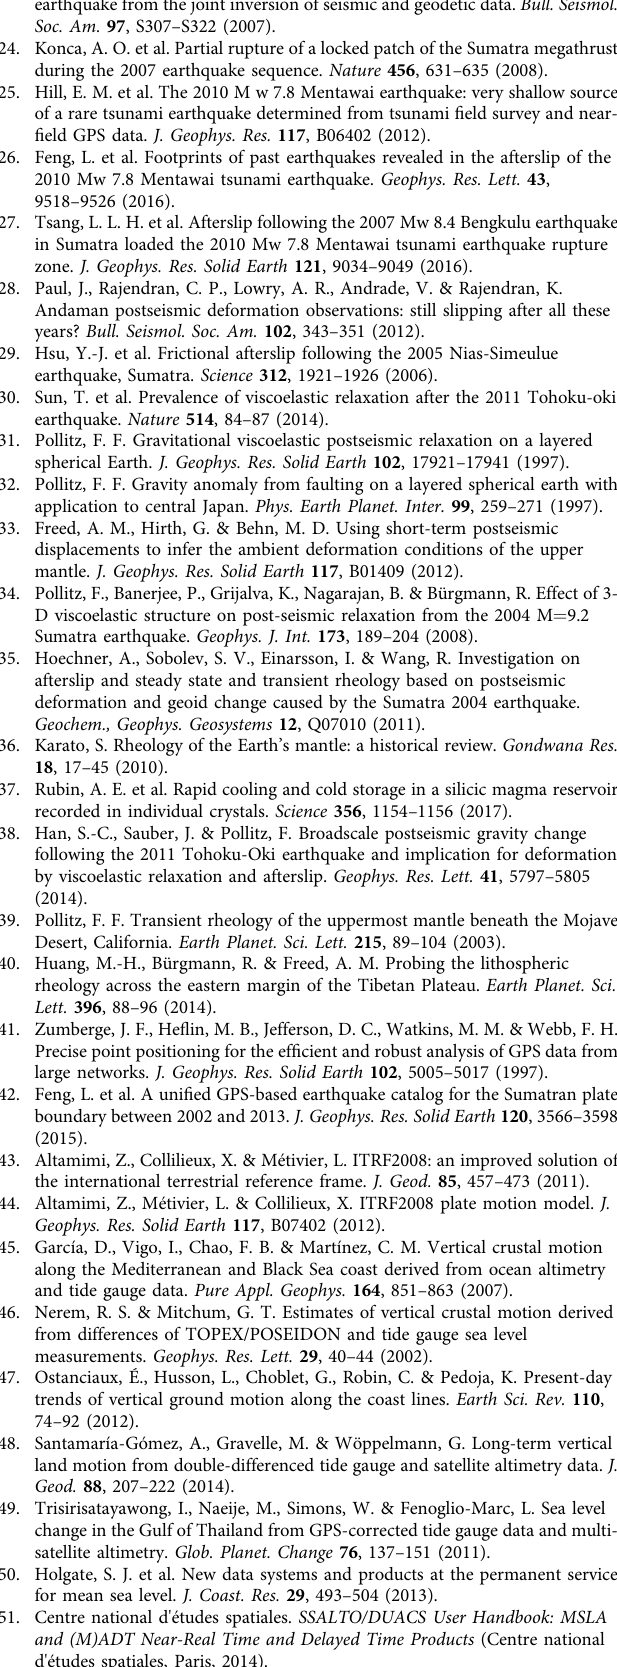
model the phase diagram of Fig. 8 using Eqs. (5 – 8) by adjusting the physical parameters manually. The best- fi t parameters for cuboid 2 are Δ τ = 24.5 kPa, τ 0